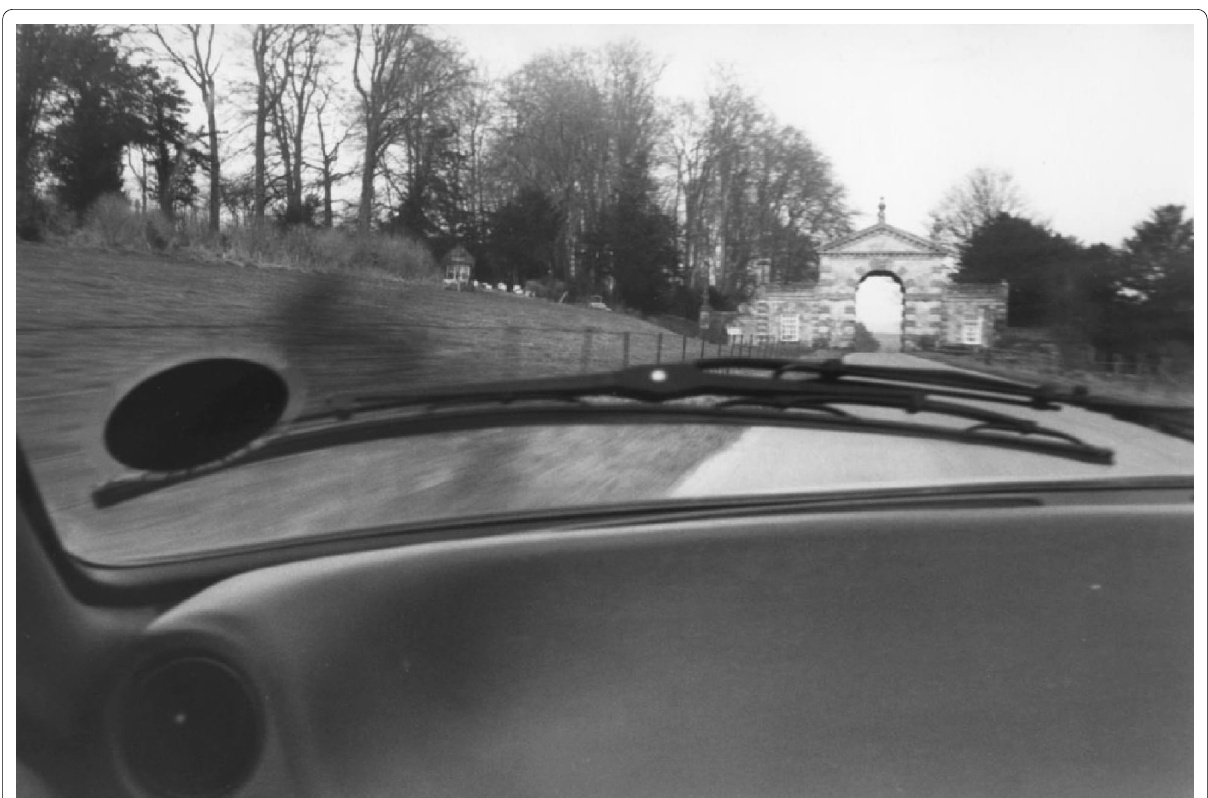
Fig. 7 Photograph taken from Citroën CX departing from Upper Lawn and approaching the outer gate of Splenders, Beckford’s father’s house. Photograph by Alison Smithson, March 1982. Credits: Smithson Family